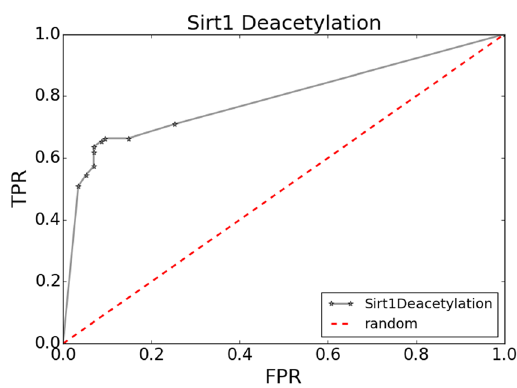
Figure 4. ROC curve of SIRT1 substrates prediction. Points on the curve were calculated with different vote number as cutoff. FPR: false positive rate, TPR: true positive